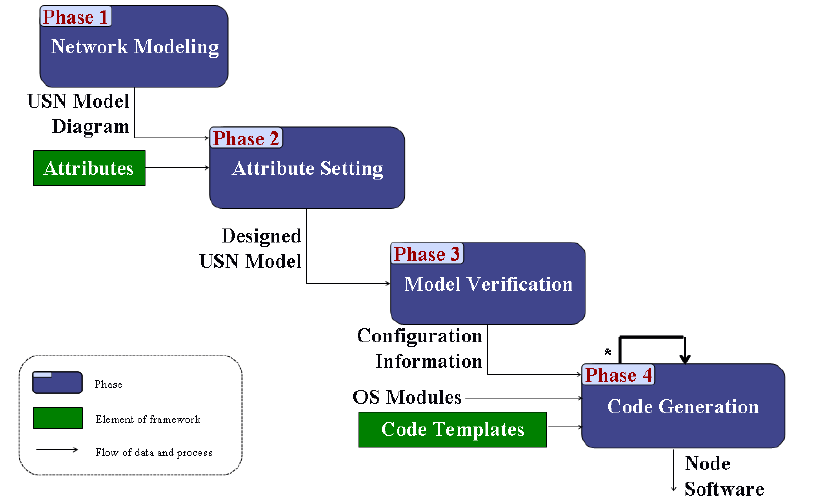
Figure 2. Construction process of USN